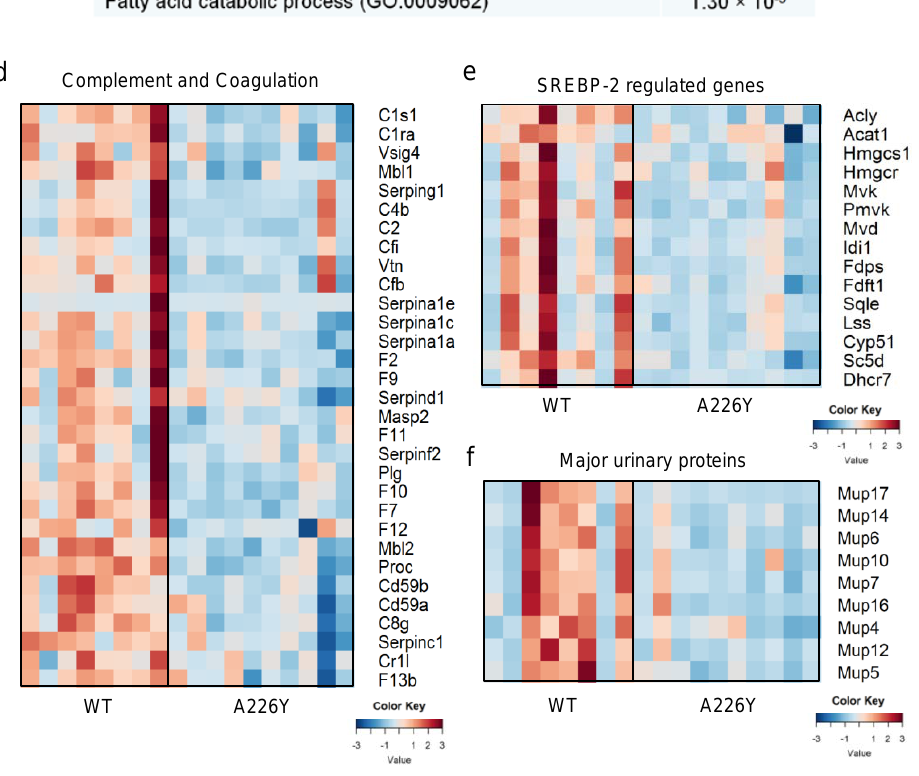
Figure 3. Upregulation of SIRT1 and transcriptional downregulation of the ER stress response in A226Y liver. ( a ) Western blot of total SIRT1 protein normalized to tubulin ( N = 5, p = 0.004). Graph shows mean, SEM, and individual data points. ( b ) Heatmap showing SIRT1 mRNA expression in the liver of WT and A226Y mice (FDR-adjusted p = 0.0096). ( c ) Curated gene enrichment list of terms downregulated in A226Y liver relating to the typical ER stress response in liver tissue; FDR-adjusted p -values are shown. ( d ) Heatmap showing mRNA expression of downregulated ( p < 0.05) genes in the KEGG pathway Complement and coagulation cascades_mmu04610. ( e ) Heatmap showing the mRNA expression of genes regulated by SREBP-2, excluding mitochondrial gene variants (gene list taken from [14]). ( f ) Heatmap showing the mRNA expression of regulated major urinary protein (MUP) genes. For transcriptome analysis, N = 8 (WT) and N = 10 (A226Y). ** p < 0.01, calculated by unpaired two-sided Student’s t -test. N = number of independent mice in each comparison. Full gel images are provided in the Supplementary